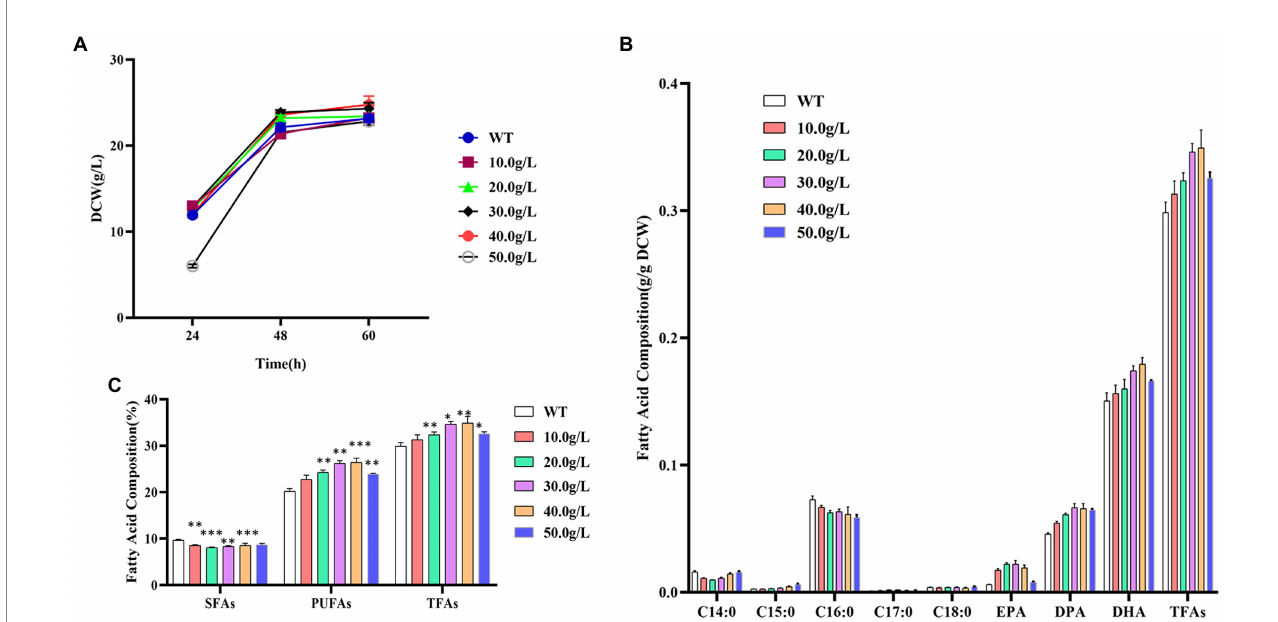
FIGURE 2 Effects of different concentrations of 1,3-propanediol on Schizochytrium ATCC 20888. (A) Growth curves; (B) Fatty acid composition; (C) Composition of saturated fatty acids (SFAs), polyunsaturated fatty acids (PUFAs) and total fatty acids (TFAs). * p -value <0.1, ** p -value <0.05, *** p -value